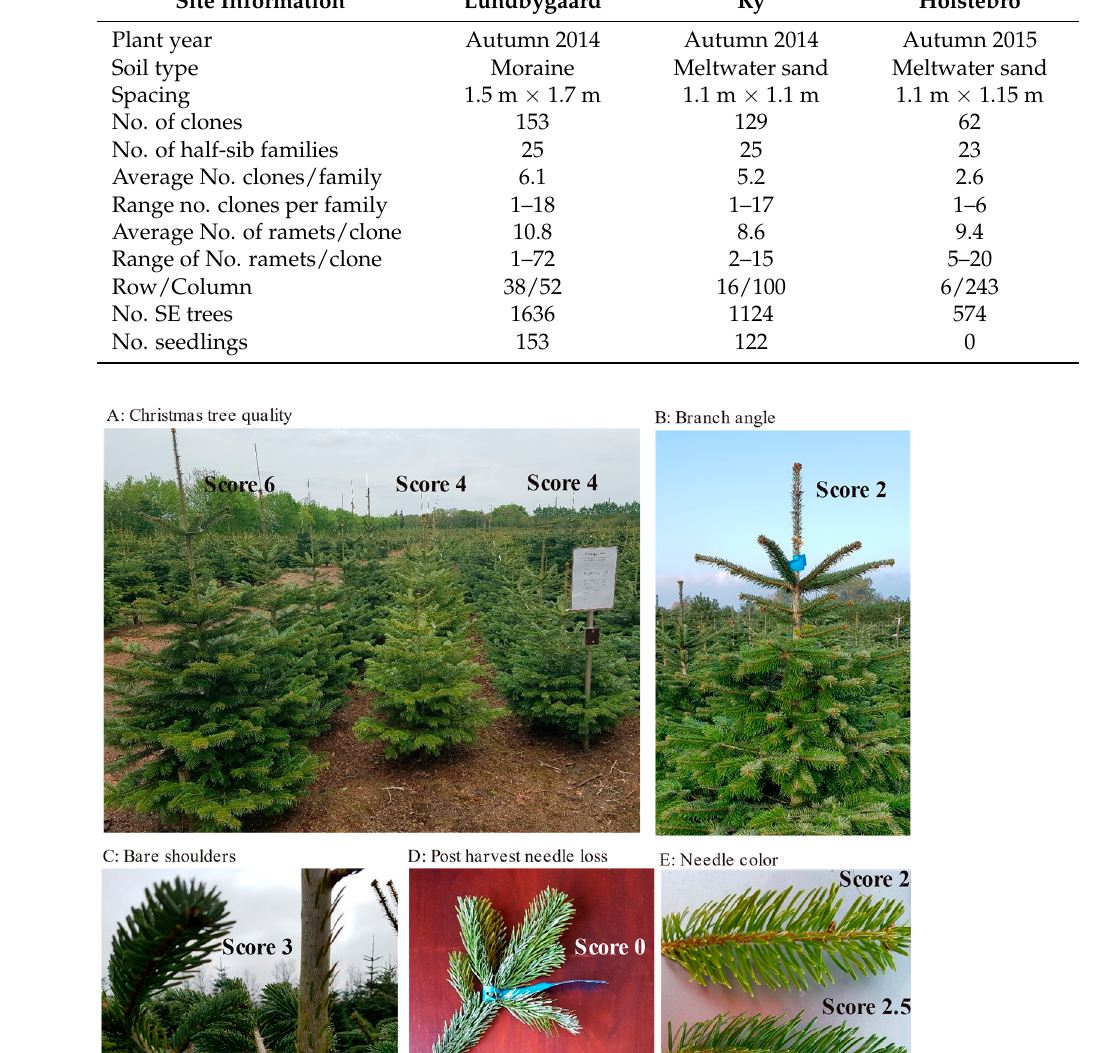
Figure 2. Location of the three SE clonal trials in Denmark.